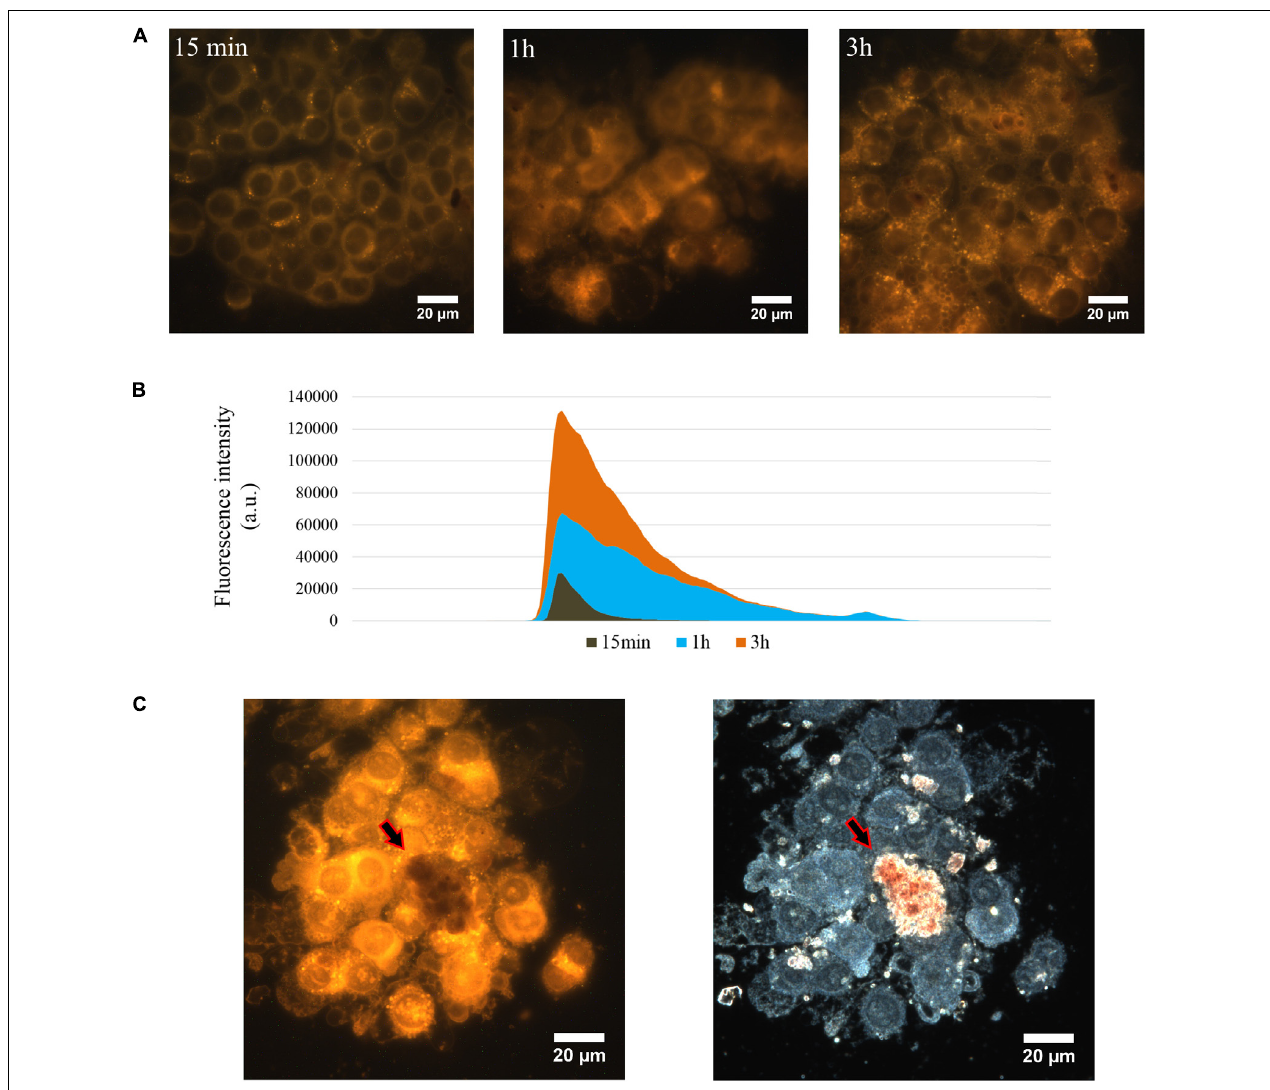
FIGURE 2 | The release of prodigiosin from p-HNTs in cytoplasm of HCT116 cells. Fluorescence images of p-HNTs-treated cells were taken after 15 min, 1 and 3 h of incubation (A) . fluorescence intensity histogram (B) demonstrated that the fluorescence intensity increased proportionally to the incubation time. Comparative analysis of dark-field and fluorescencee images (C) demonstrates the absence of extracellular leakage of prodigiosin. The arrows indicate the red colored p-HNTs aggregate on the cell surface which cannot be visualized on fluorescent